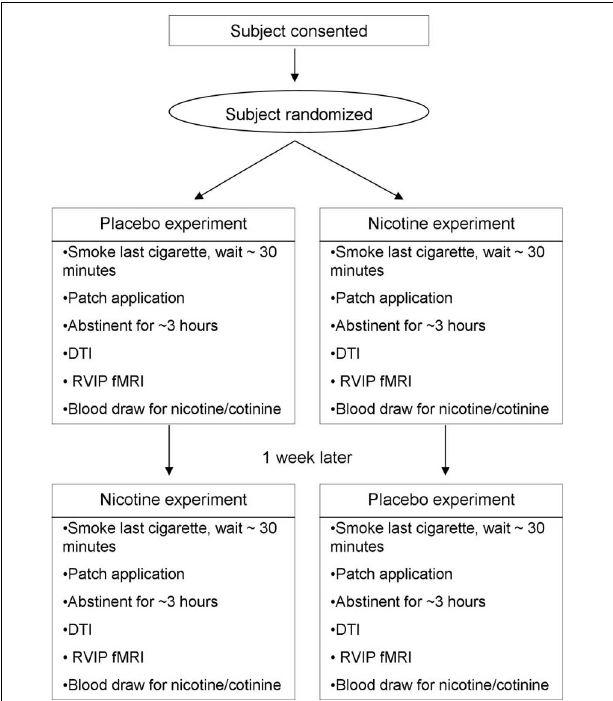
FIGURE 1 | Schematic diagram of the clinical trial procedure for the discovery sample. The procedure for the replication sample was essentially the same, but without the RVIP